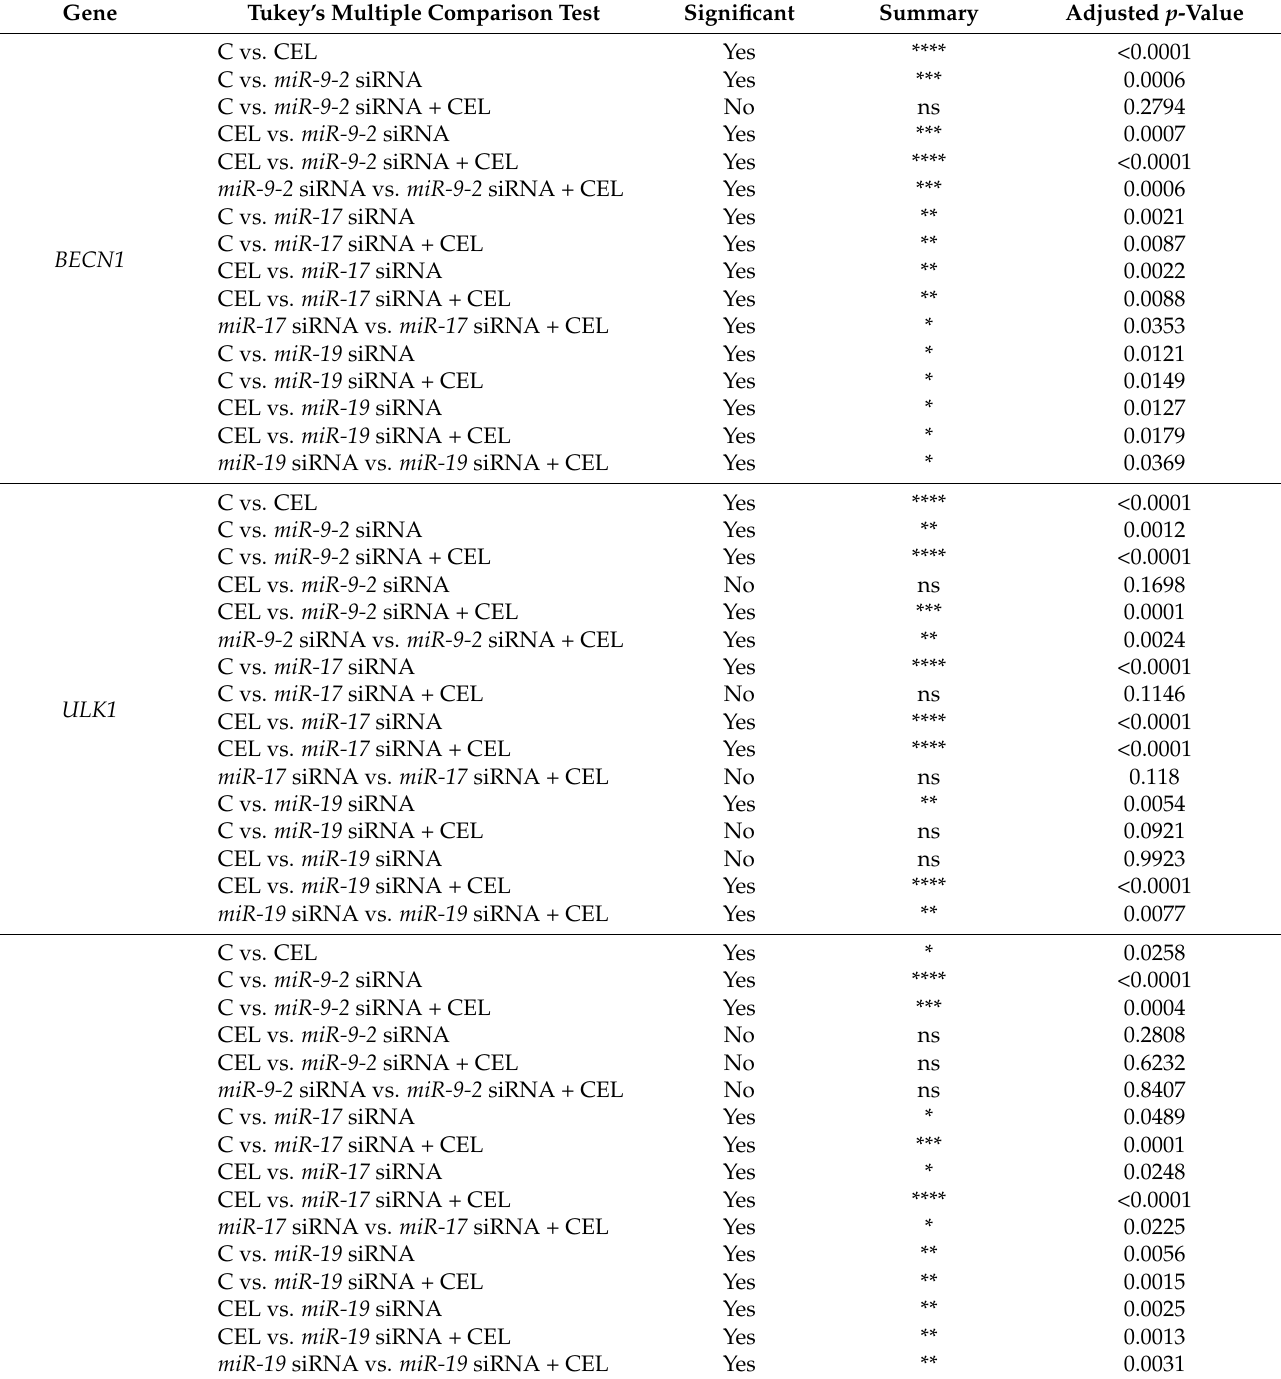
Table 6. Results of the one-way ANOVA followed by Tukey’s post-hoc test in Figure 4.